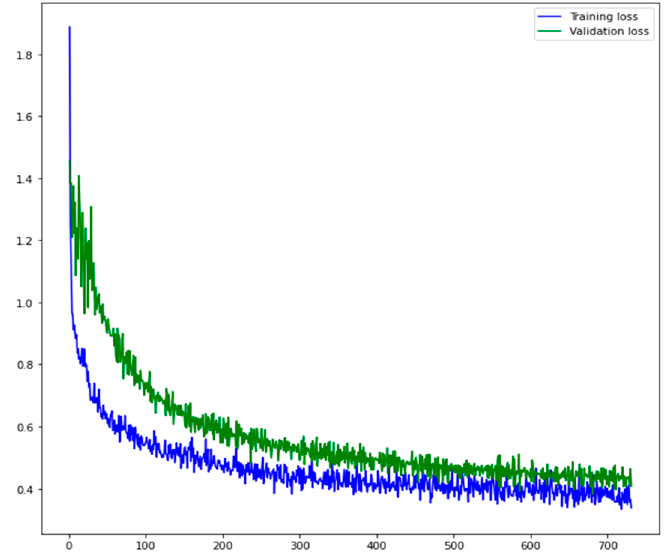
Figure 10. Training and validation loss profile over the number of epochs, which is the number of times the learning algorithm update the model by analyzing the entire training dataset. The two curves show the performance improvement on training and validation data.